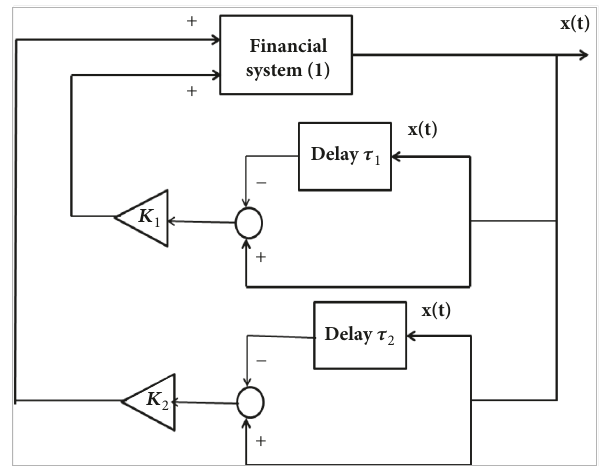
Figure 1: The delayed feedback control